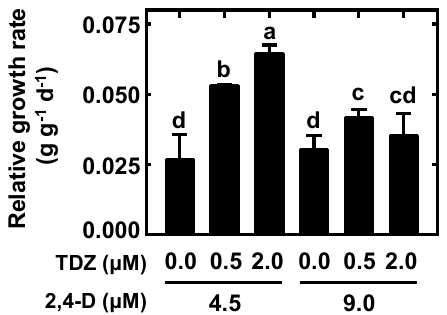
Figure 2. The effects of 2,4-D and TDZ on callus proliferation. Calli were cultured on the MS medium containing 3% sucrose and different plant growth regulators. Data (mean ± SD) with different letters